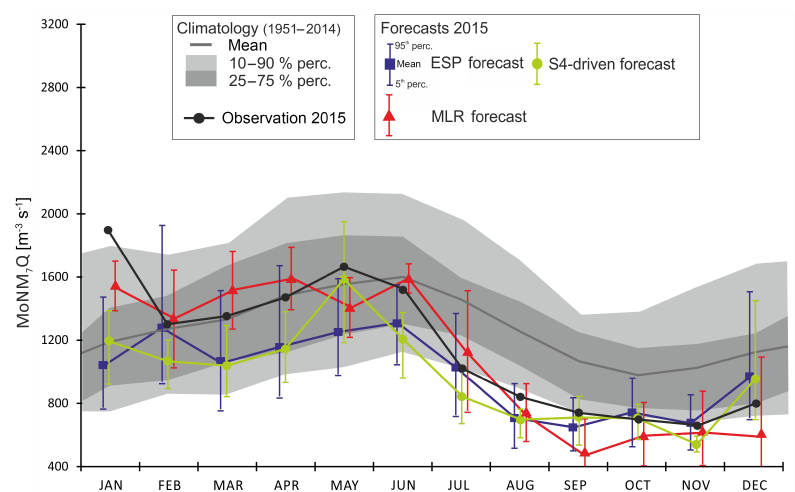
Figure 12. Comparison between the three navigation-related forecast approaches for the lowest 7-day mean MoNM 7 Q of the current month in the year 2015 at gauge Kaub/Rhine in relation to the observed values and the climatology (1951–2014).